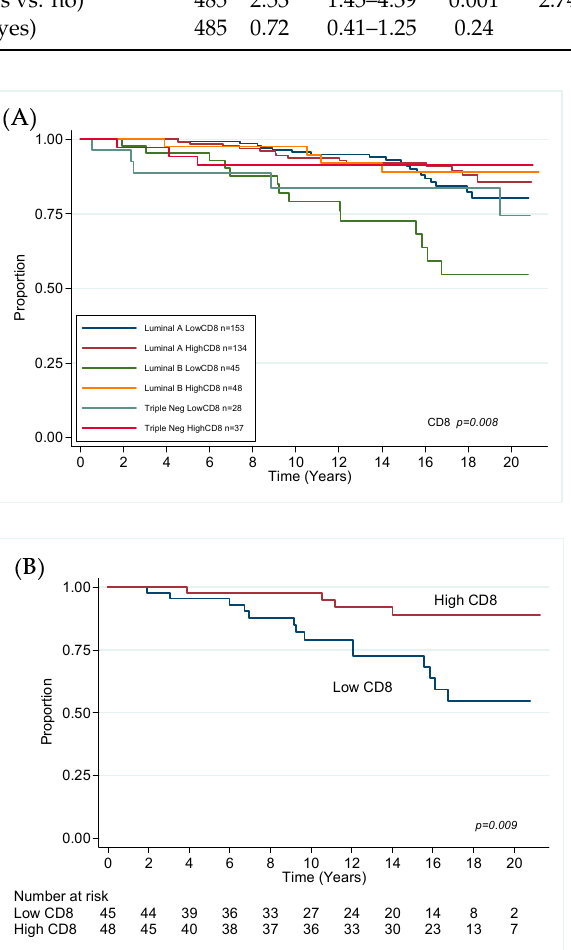
Figure 4. ( A ) Kaplan–Meier estimates for local recurrence in the whole cohort and ( B ) in luminal B cancer, stratified by CD8 expression.